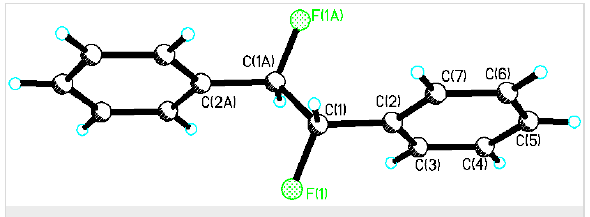
Figure 1: Crystal structure of erythro - 13 .